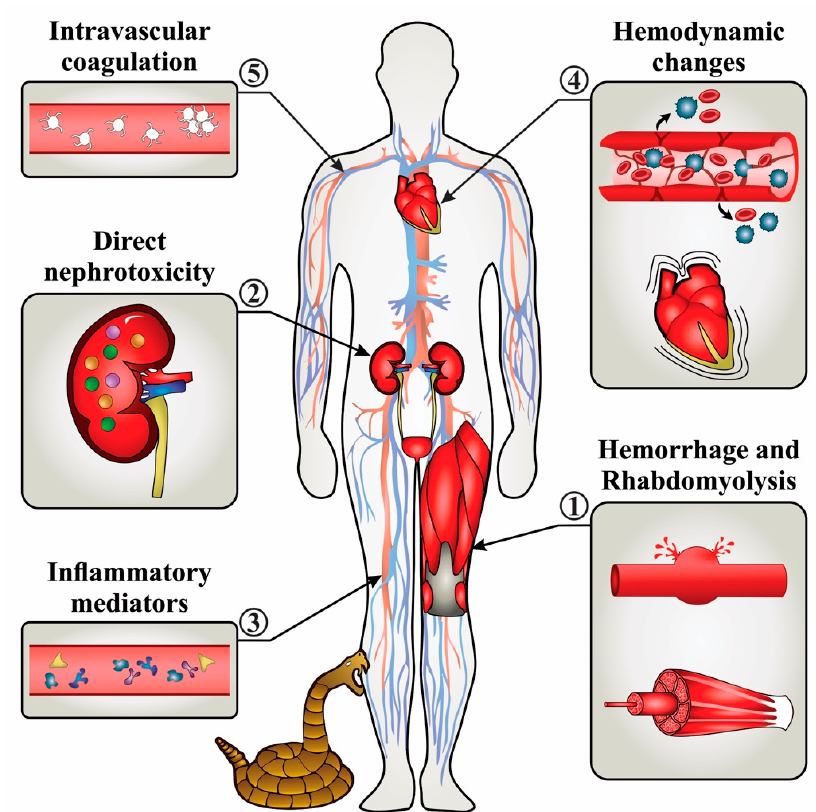
Figure 3. Mechanisms of acute kidney failure (AKF) induced by crotalic venom. AKF occurs in consequence to the acute kidney injury (AKI), which is defined by a sudden decrease in kidney function. Snake toxins trigger several mechanisms to induce AKF. ( 1 ) Venom-induced hemorrhage and rhabdomyolysis, which results in hematuria and myoglobinuria, induce direct tubulotoxicity, renal tubular obstruction, and secondary decreased of glomerular filtration [54–56]. This kidney injury is also referred to as pigment-induced nephropathy [57]. ( 2 ) Direct e ff ects of snake venom toxins on kidneys (i.e., direct nephrotoxicity) are reported as well [58]; however the precise mechanism of injury remain to be elucidated. ( 3 ) Inflammatory mediators (i.e., IL-6, TNF- α , and IL-1 β cytokines, prostaglandins, leukotrienes, and proteins from complement system such as C3a, C4a, and C5a) are also involved in the pathogenesis of AKI [59,60]. ( 4 ) Hemodynamic changes, such as hypotension, and hypovolemia caused by venom compounds (e.g., phospholipases A 2 , natriuretic peptides, serine proteases, and vascular endothelial factor), decrease vascular resistance, increase cardiac output, and increase renal vascular resistance, with the latter causing hypovolemia [61]. ( 5 ) Coagulation activation, specifically disseminated intravascular coagulation, results in thrombotic microangiopathy, which decreases renal blood flow and contributes to AKI [62].